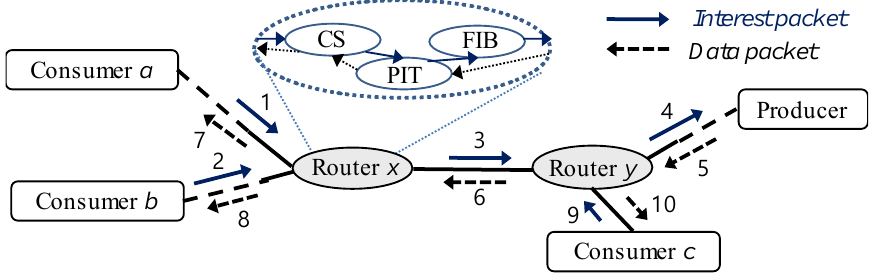
Figure 1. Example of packet forwarding when three consumers issue the identical interest packet in named data networking (NDN).